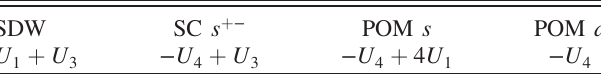
TABLE I. The interactions in different channels along the stable fixed trajectory. Positive sign of an interaction implies an attraction. All interactions scale as 1 = ð L 0 − L Þ and diverge at RG scale L 0 . We use these interactions to compute vertices and susceptibilities in SDW channel, s þ − superconducting channel, and s -wave and d -wave Pomeranchuk channels (POM s and POM d ). SDW SC s þ